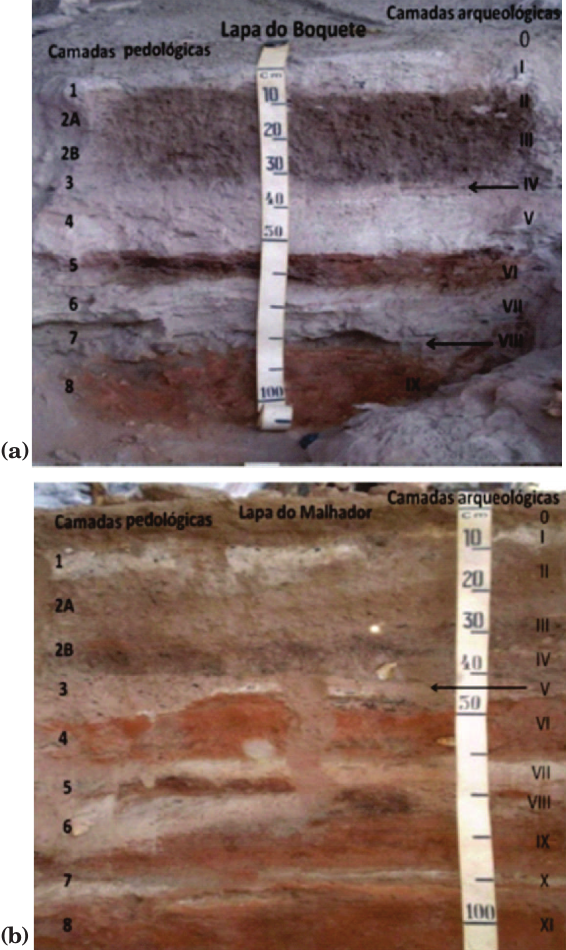
Figura 1. Perfis coletados dos solos das Lapas do Boquete (a) e do Malhador (b) no PARNA Cavernas do Peruaçu e a divisão das camadas, evidenciando as pedológicas e as